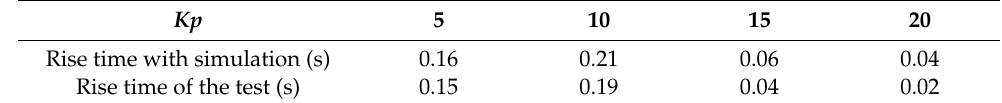
Table 1. Test and simulation results of sensor with different proportional term K p .